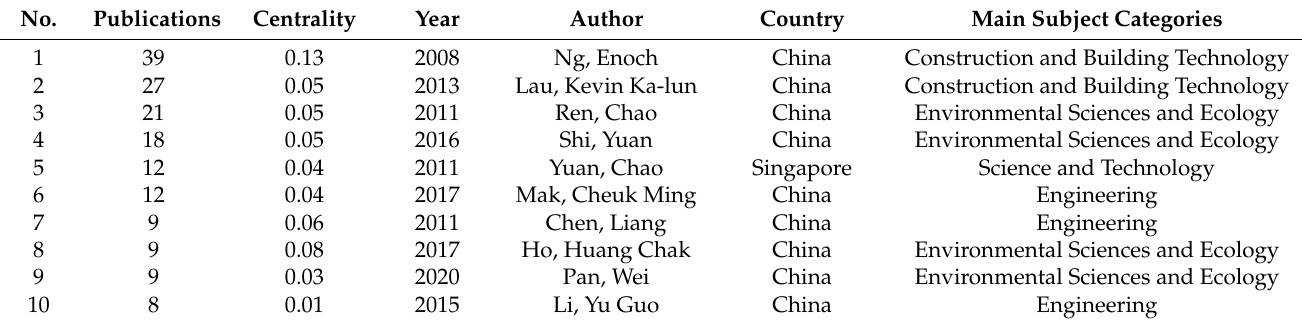
Figure 5. Knowledge map of the major authors of high-density city research from 2001 to 2022. Table 4. Major authors of high-density city research from 2001 to